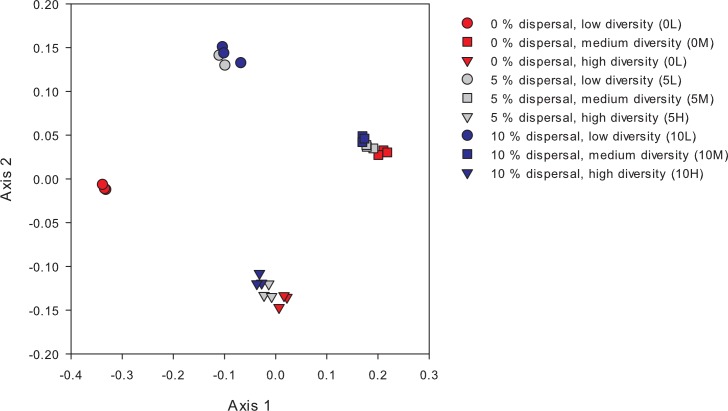
NMDS ordination presenting differences in bacterial community composition between treatments at the end of the experiment.Cultures differed in the level of dispersal: 0% (0), 5% (5) or 10% (10) as well as in their initial diversity: low (L), medium (M) and high (H). K-stress (2D): 0.11.